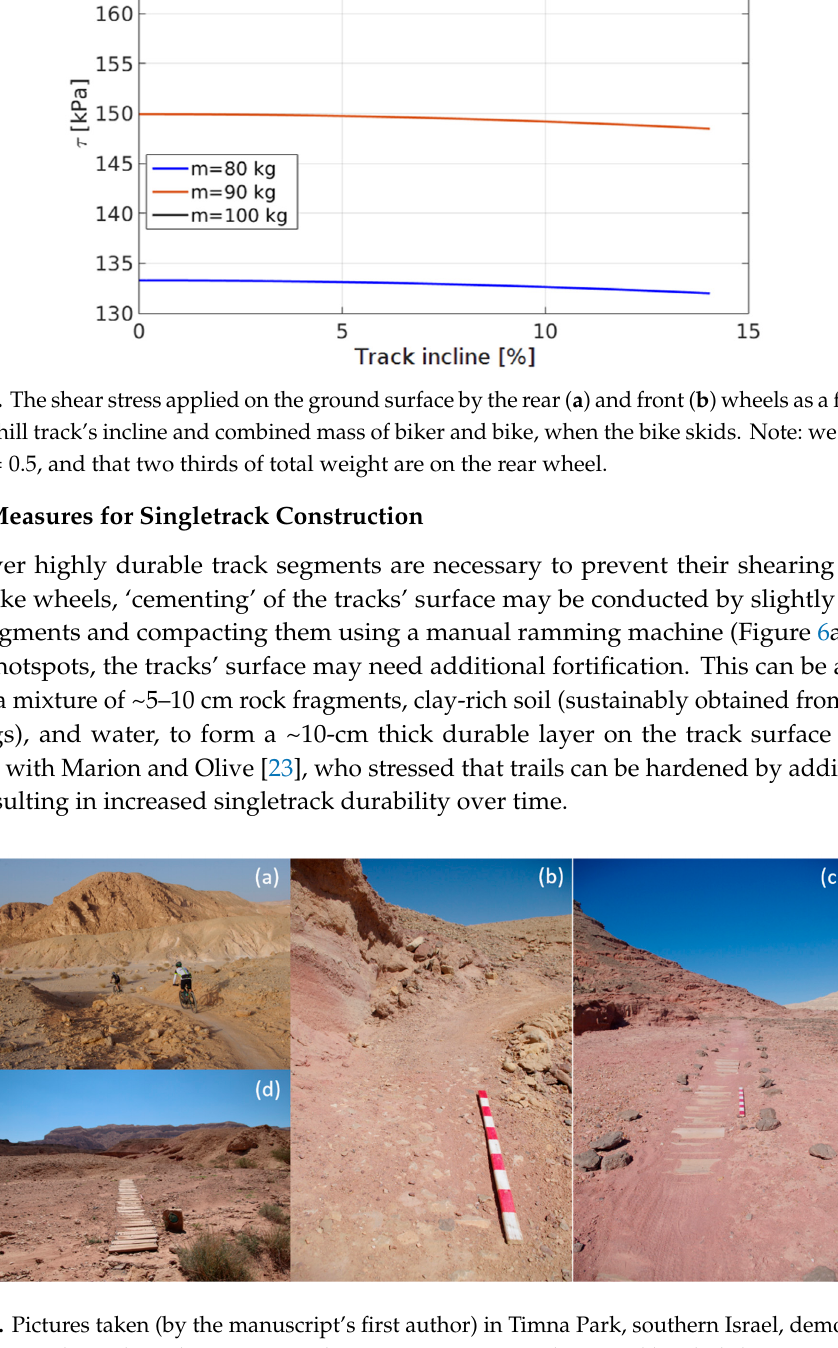
Figure 6. Pictures taken (by the manuscript’s first author) in Timna Park, southern